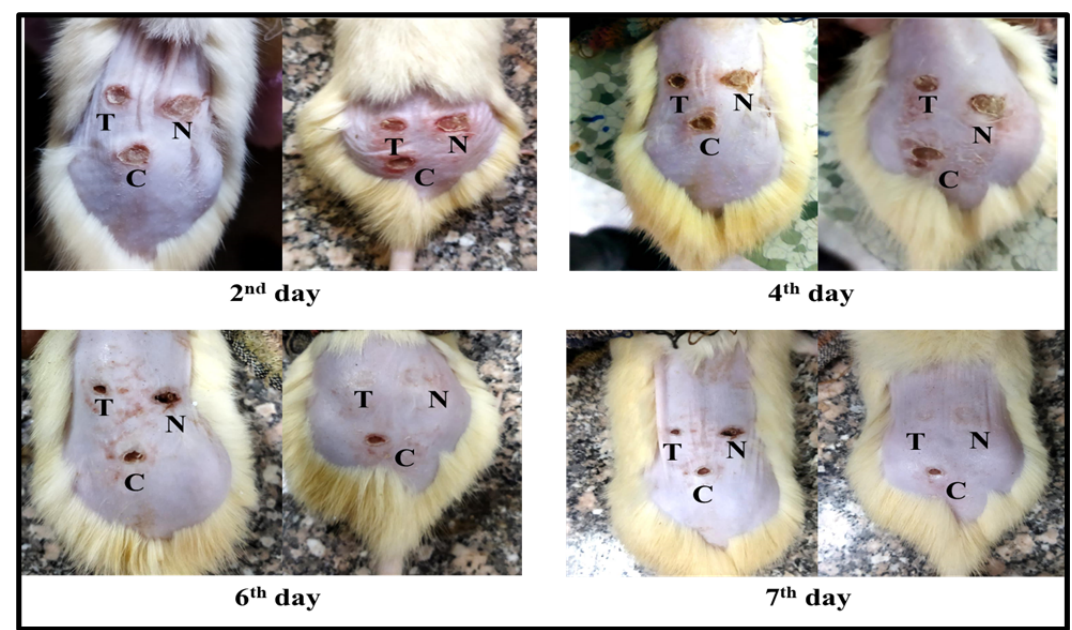
Figure 6. Burn induction in rats showing the healing process of burned areas of two representative rats at different time intervals, where N = negative control, the burn was treated daily with normal saline; C = control, the burn was treated daily with the cream base only (reference group); and T = test group, the burn was treated daily with levan mixed with cream base at concentration 0.25 g levan/5 g cream. Table 2. Percentage of burn area contraction.